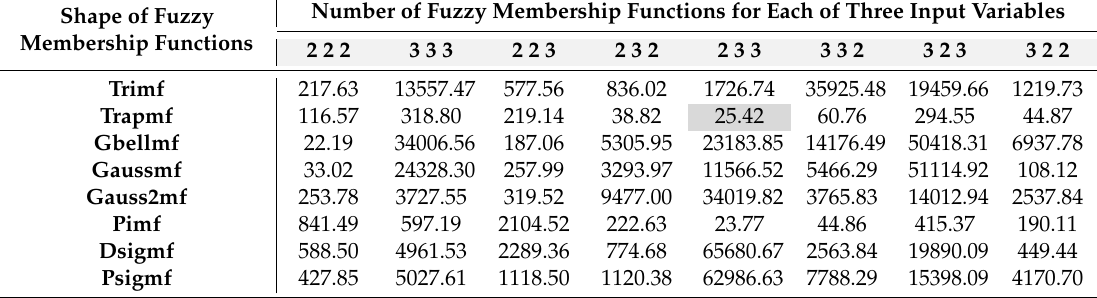
Table 6. The values of average testing errors of different ANFIS models with linear output. Shape of